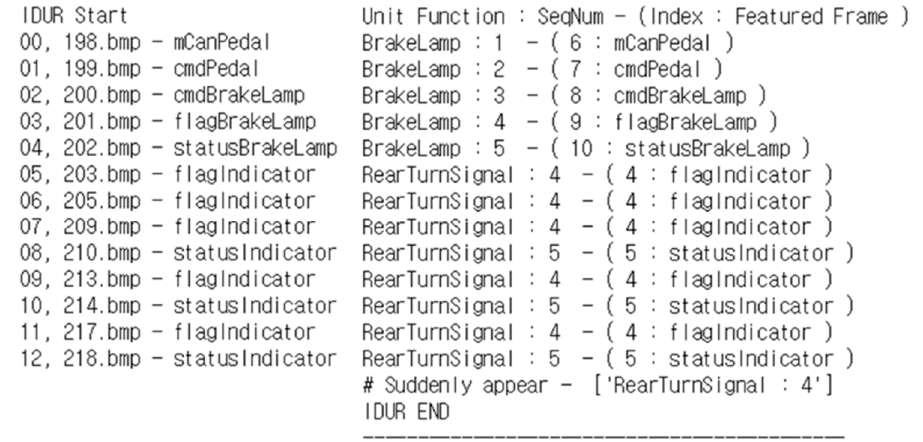
Figure 13. Finding the fault-occurrence point of fault index #12.